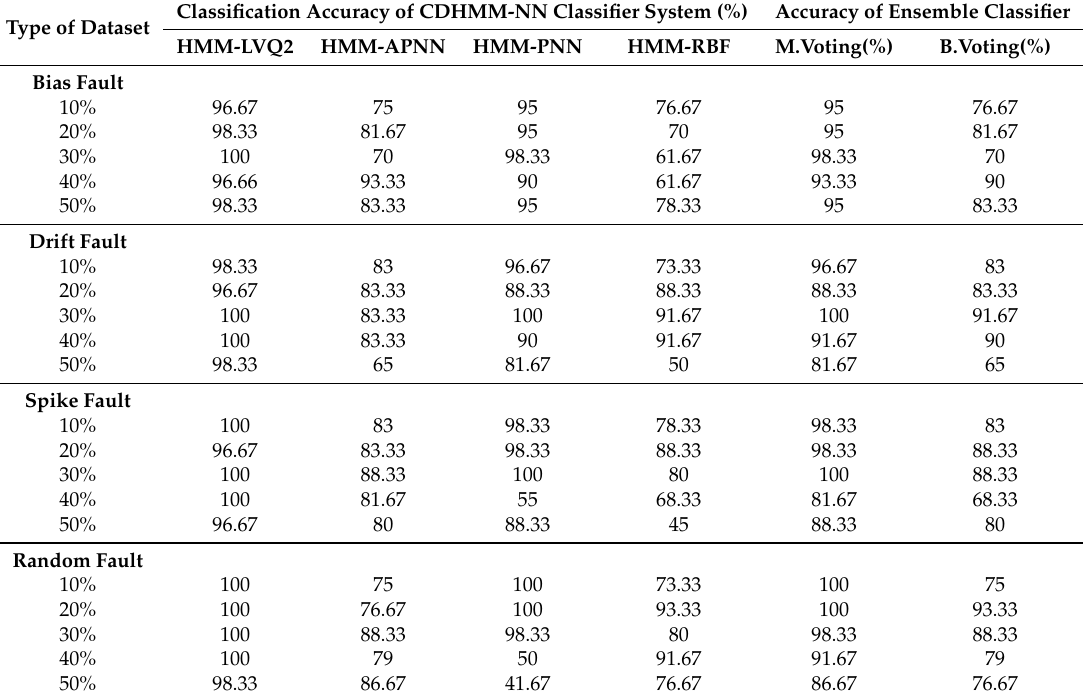
Table 3. Classification accuracy of hybrid continuous density hidden Markov model (CDHMM)-NN ensemble classifier system with different voting